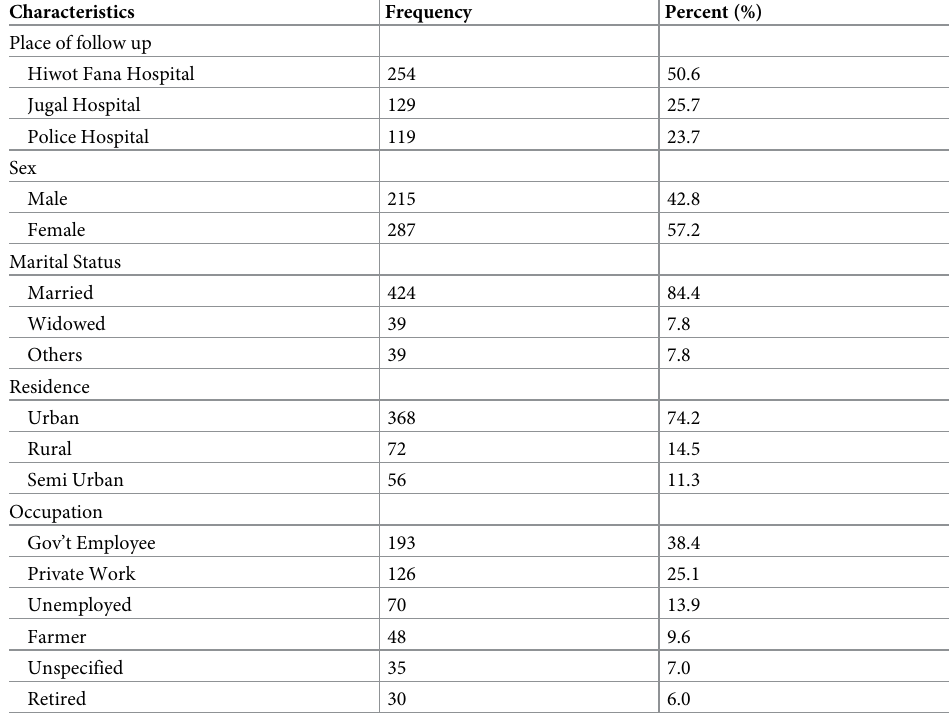
Table 1. Socio-demographic characteristics of T2D patients at government hospitals in East Ethiopia from 2013 to 2017.